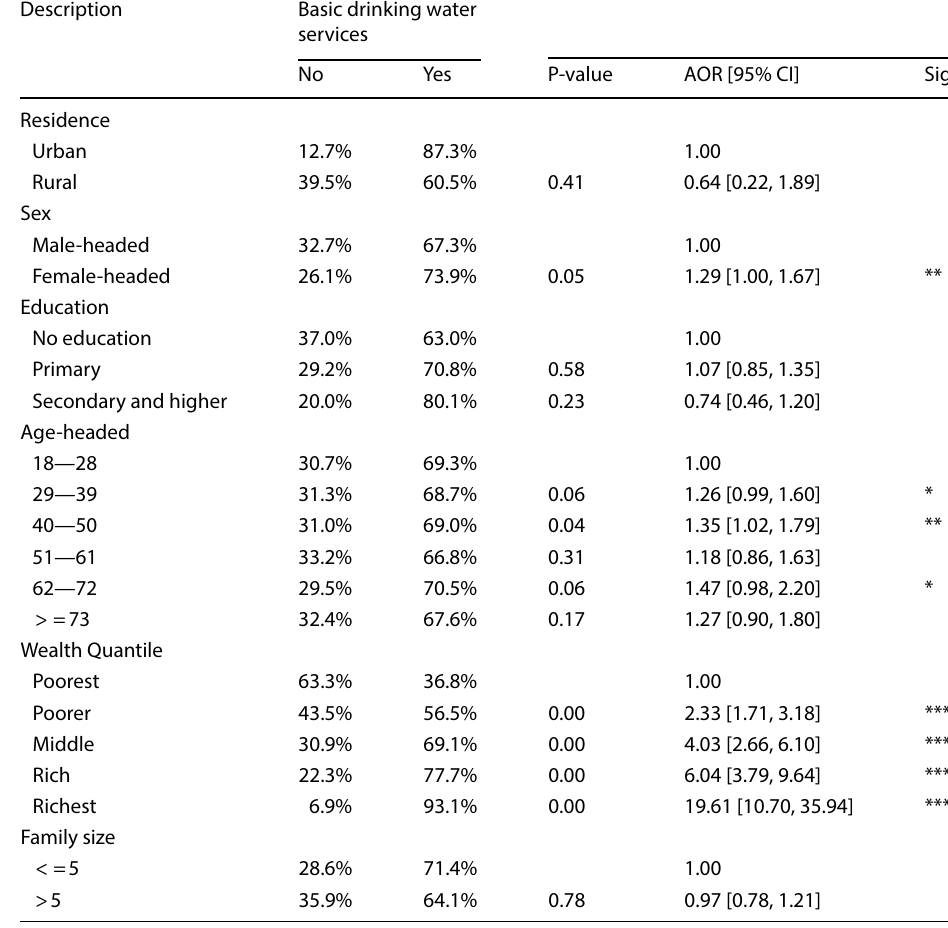
Table 2 Multivariate logistic regression analysis for basic drinking water service ladder with selected explanatory variables among respondents for 2019 EDHS